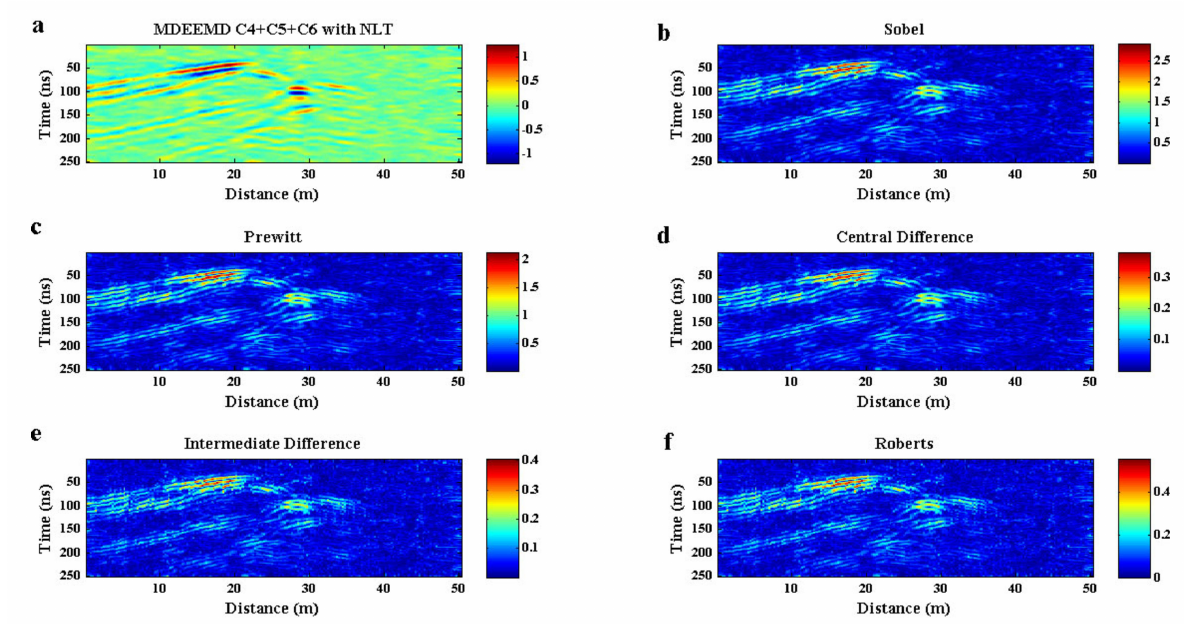
Figure 8. Two-dimensional edge maps of the realistic model study with MDEEMD. Various edge detectors, subplots ( b–f ), are applied to the noise-corrupted profile after the MDEEMD processing, where component C4 + C5 + C6 with NLT (subplot ( a )) is used as the reconstructed profile for performing edge detection.